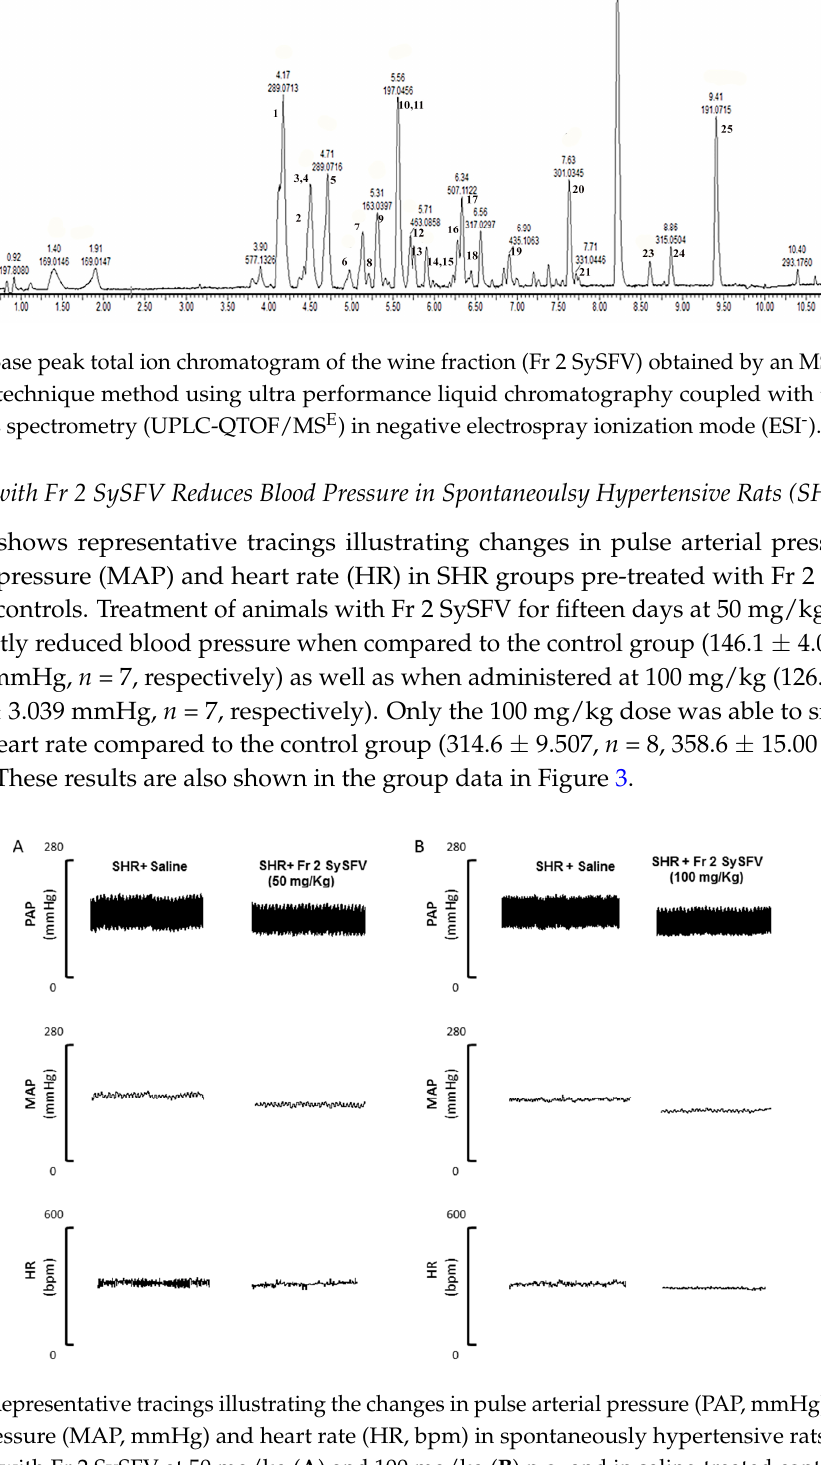
* Peak number as marked in the chromatogram shown in Figure 1; ND—representative fragments were not detected; a positional isomers.